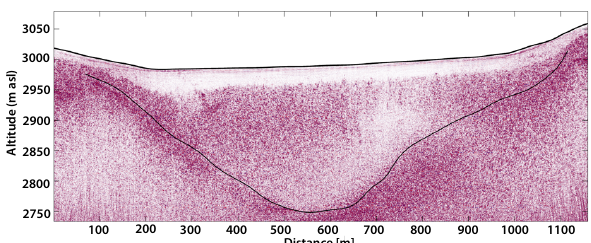
Fig. 3. Processed GPR section across Glacier d’Otemma. Its posi- tion is indicated in Fig. 2.